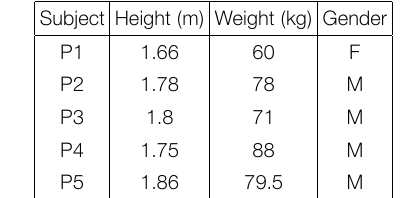
Table 2. Main physical body characteristics of the experiment participants.